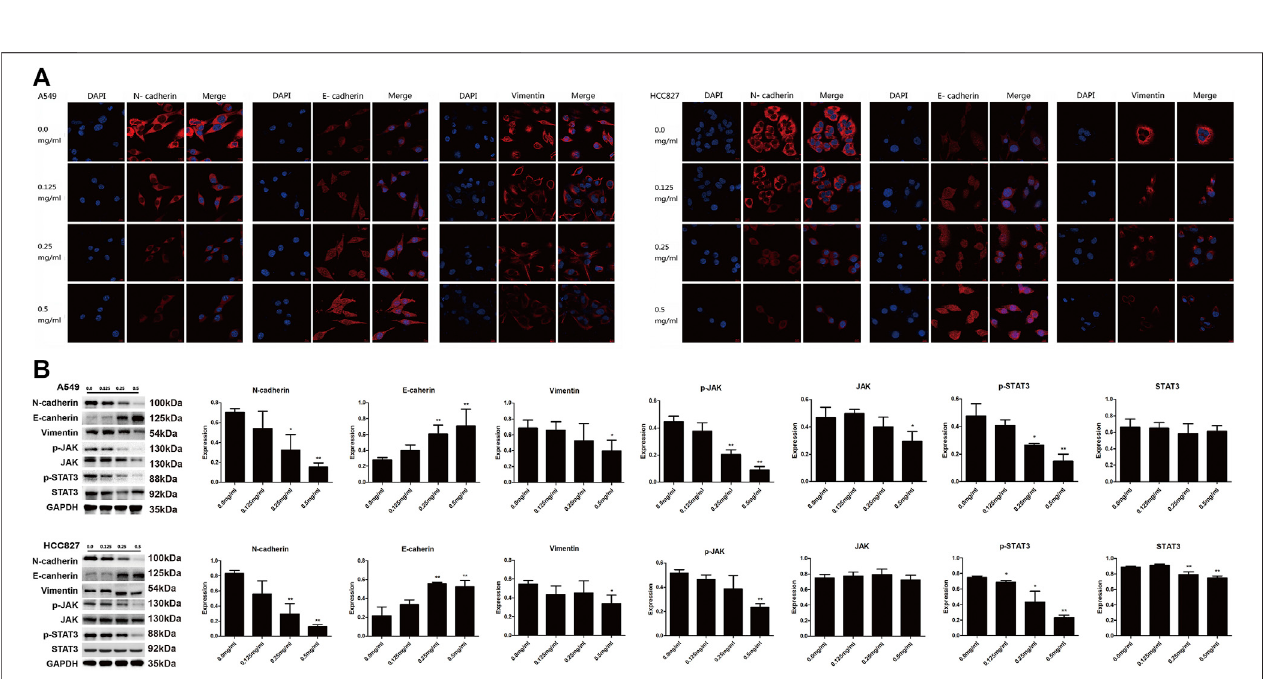
FIGURE 6 | AETW decreased the expressions of EMT markers and JAK/STAT3 signaling regulators. Confocal microscope inspections (A) and immunoblot analyses (B) of the expressions of cadherins, vimentin, and JAK/STAT3 axis signaling proteins using the corresponding antibodies. Compared with the fi rst group, * p < 0.05 , ** p < 0.01